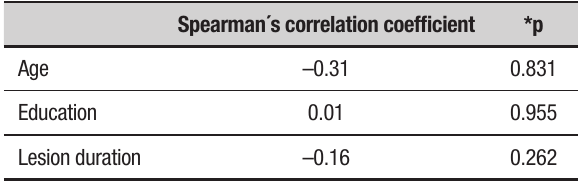
Table 1. Association between therapy time and age, education and